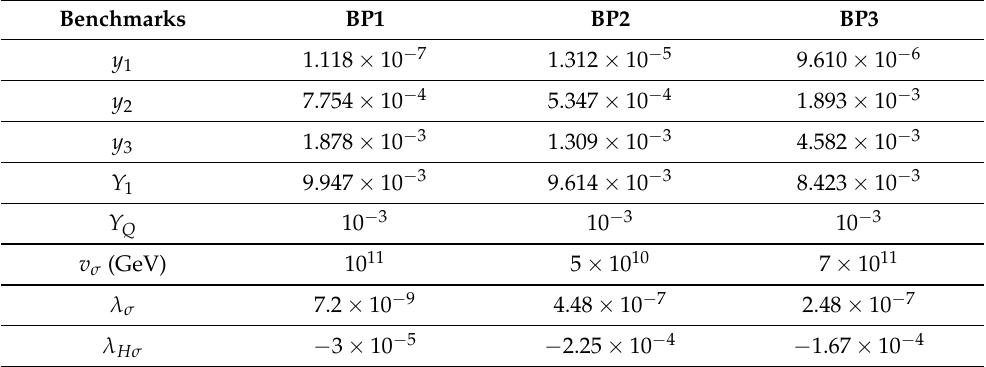
Table 1. Used benchmark points (BP) in our analysis. Note that we assume specific texture to right-handed neutrino Yukawa matrix Y n .